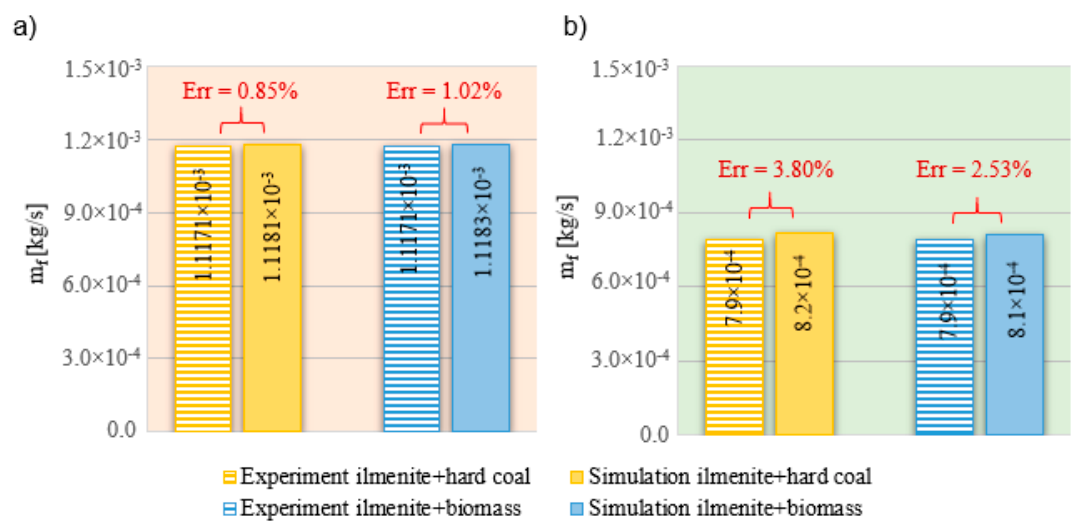
Figure 12. Experiment and simulation results for gas mass flow rate: ( a ) AR ( b ) FR.